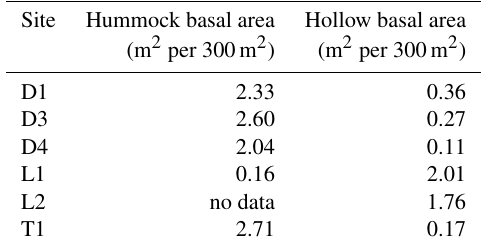
Table 2. GLMM results for species richness versus relative eleva- tion.